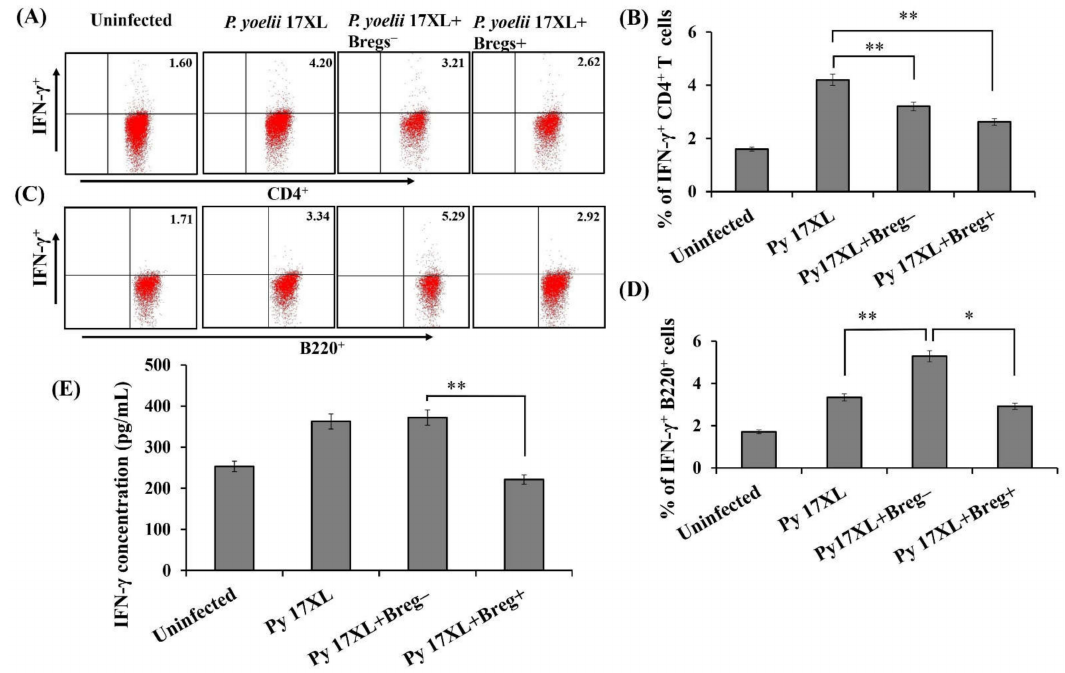
Figure 5. Adoptive transfer of regulatory B cells and its effect on pro-inflammatory immune response: Infusion of regulatory B cells modulates the immune response by altering IFN- γ cytokine profile. Splenocytes were harvested from spleen obtained at day 9 after infection from Py 17XL infected mice either intravenously infused with Breg + or Breg − cells. Harvested splenocytes were incubated with anti-IFN- γ , anti-B220 and anti-CD4 antibodies. ( A , C ) Flow cytometric analysis represents the IFN- γ expression on CD4 + T-cells and B220 + B cells in uninfected control, P. yoelii 17XL infected mice and P. yoelii 17XL infected mice either infused with either Breg + cells or Breg − cells ( n = 12). ( B , D ) Bar graph representing the percentage of IFN- γ on T cells and B cells. ( E ) Serum was harvested after 9 days of adoptive transfer of regulatory B cells in syngeneic Balb/c mice and IFN- γ expression was measured by Multiplex microarray bead-based system. Data is represented as mean ± SD of 9 mice combined from three independent experiments and unpaired two-tailed Student’s t -test was used to calculate statistical significance (* p < 0.05, ** p <